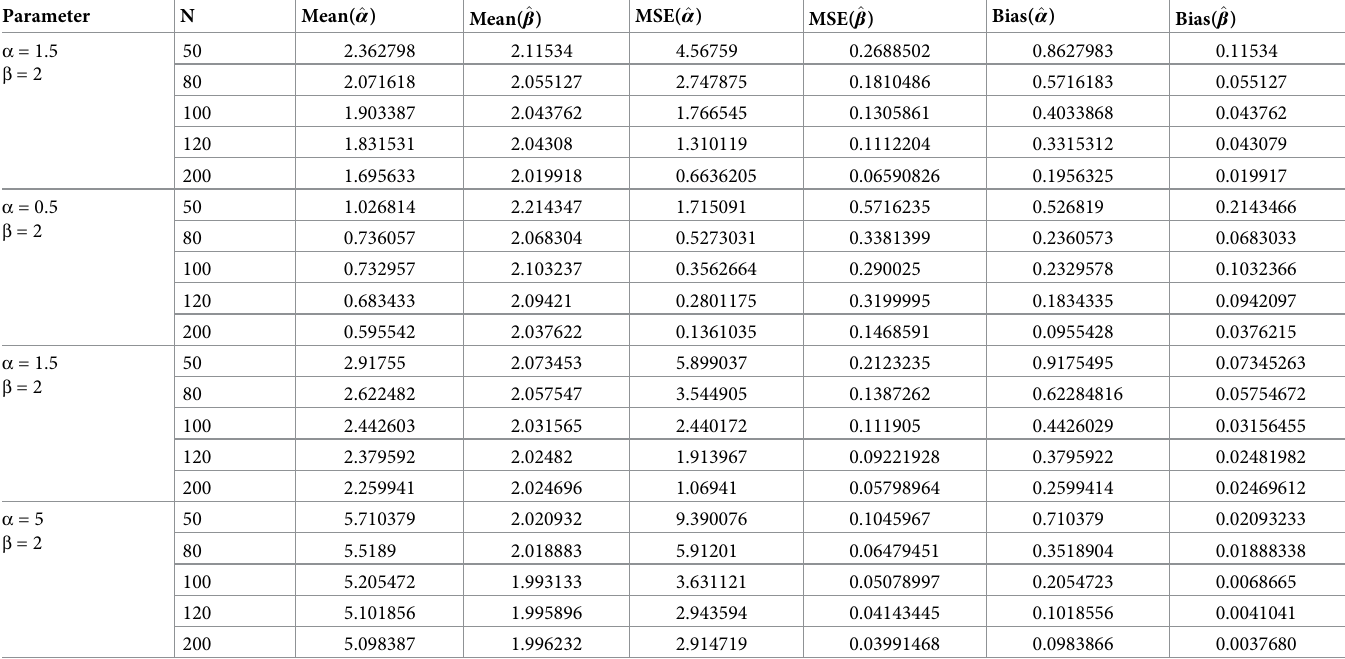
Table 2. Average values of MLE, corresponding MSE and